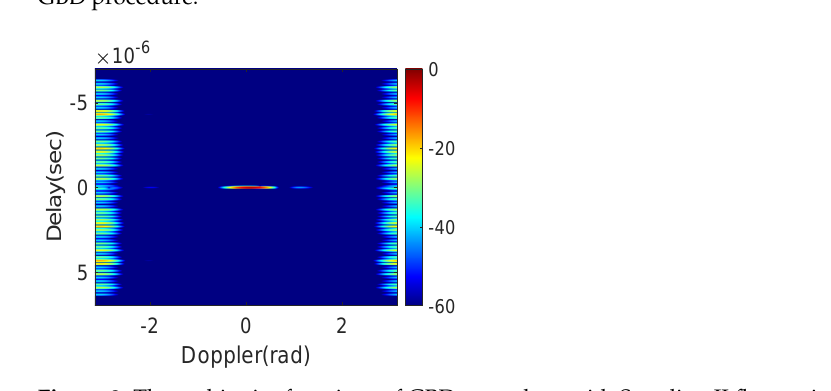
Figure 8. The ambiguity functions of GBD procedure with Swerling II fluctuation.